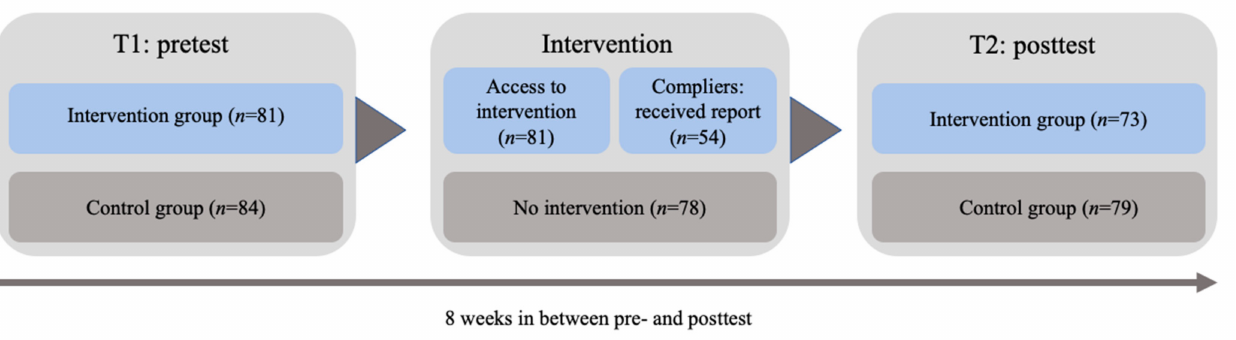
Figure 1. Intervention